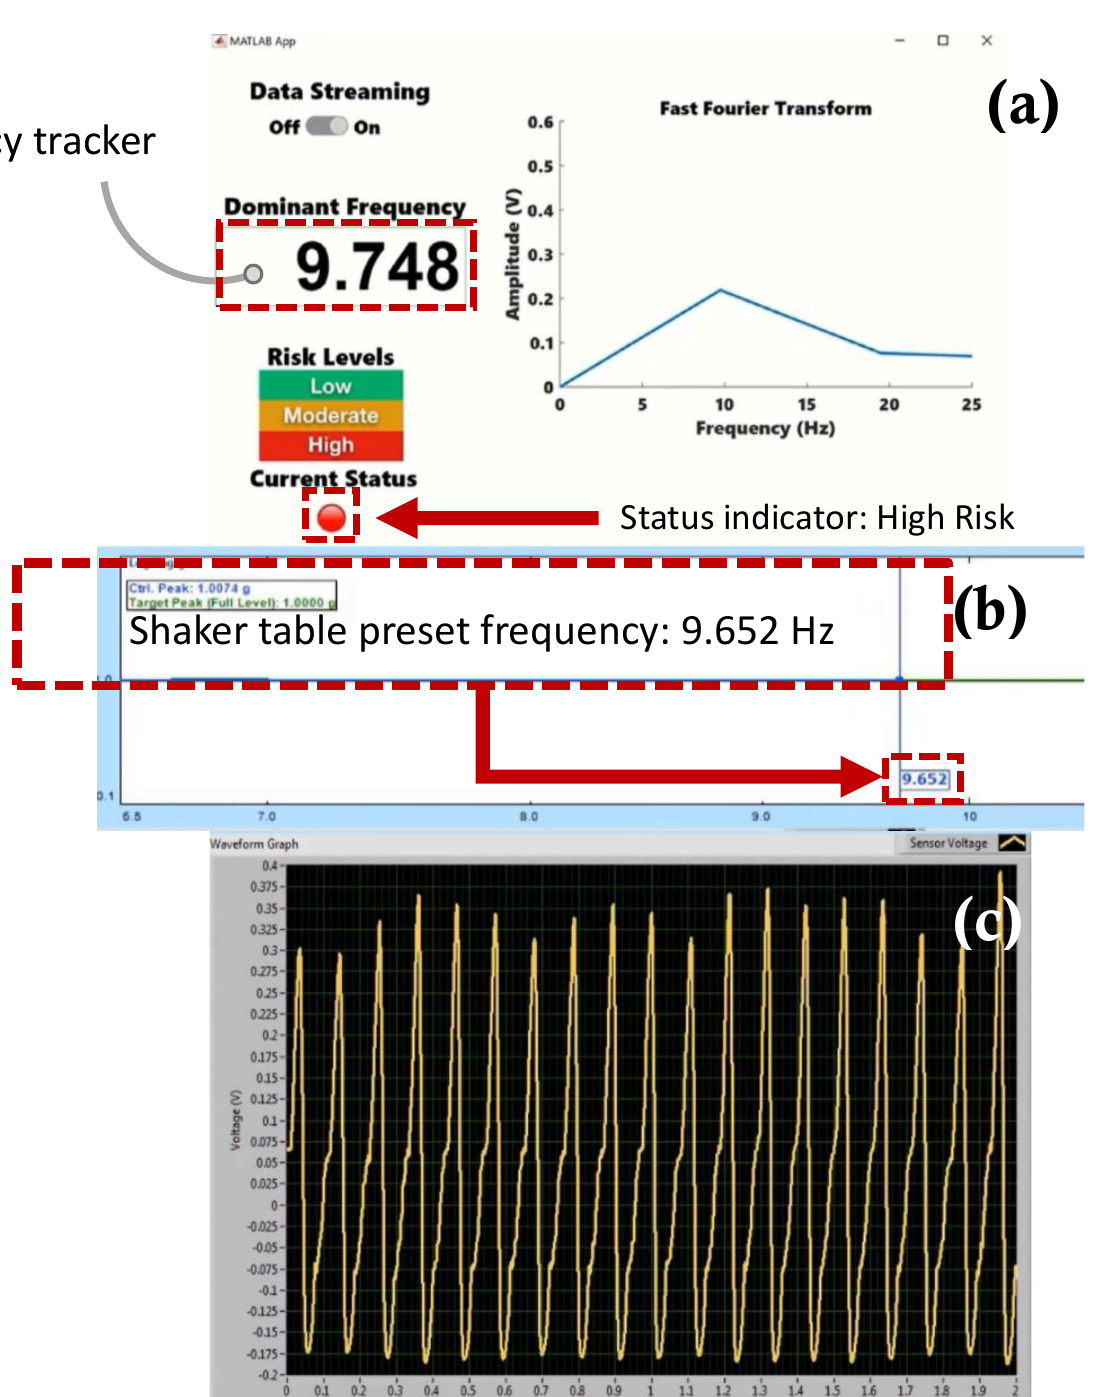
Figure 18. Screen captures of the self − powered, self − contained, vibration sensor system taken from the demonstration experiment: ( a ) custom developed fault detection app with a frequency tracker feature and status indicator for risk monitoring, ( b ) EDM shaker table vibration control software with preset frequency monitor, and ( c ) sensor voltage waveform monitor at preset frequency 9.652 Hz.